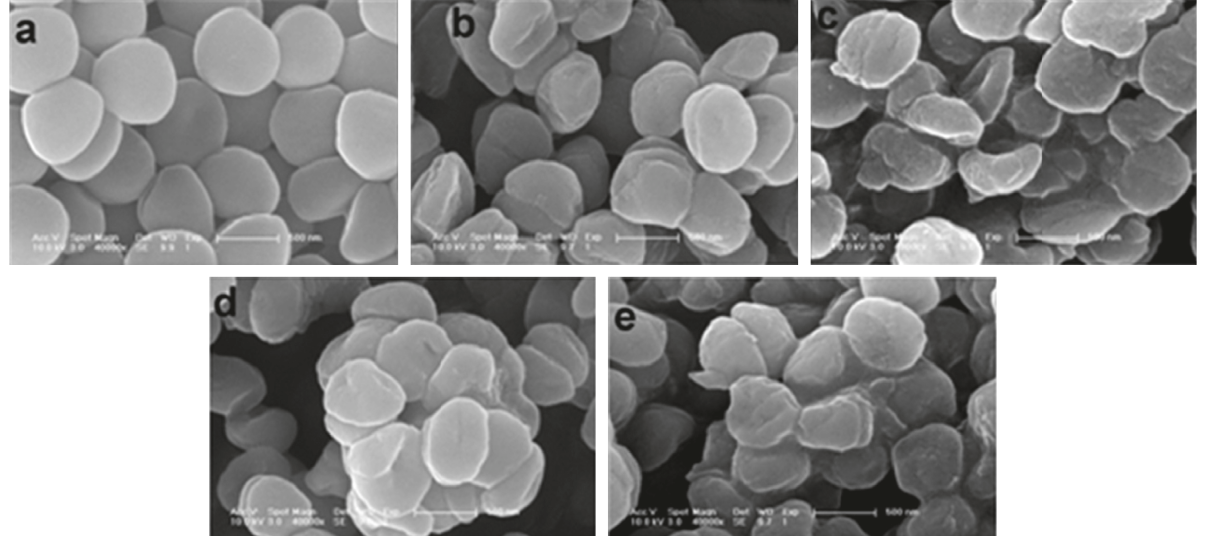
Figure 2: SEM images of Staphylococcus aureus strains USA300 untreated (a) and treated with 3 (b), 4 (c), 5 (d), and 6